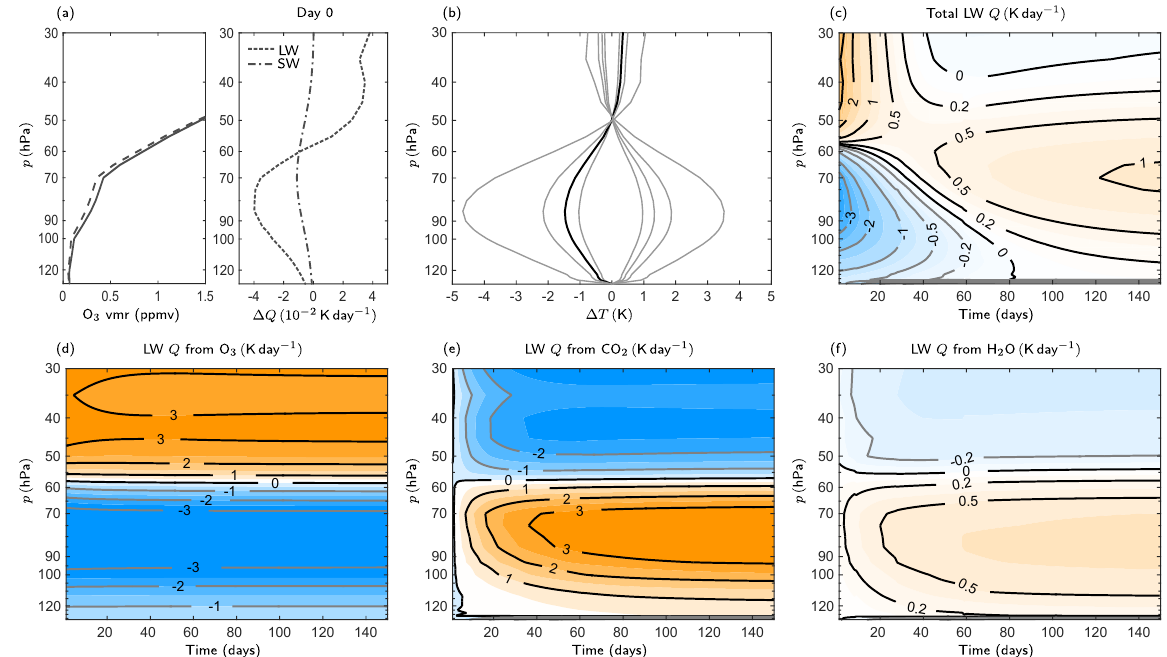
Figure A1. (a) Left: ozone reference profile (solid) and perturbed profile (dashed) used in the FDH calculation. Right: instantaneous change in heating rate from perturbation. (b) Temperature change resulting from the ozone perturbation. The calculation is done at the Equator on 1 January. The lines correspond to perturbations of A 0 = − 0 . 2, − 0.1, − 0.07 (black line), − 0.05, 0.05, 0.07, 0.1, and 0.2ppmv from left to right at the maximum temperature change (see text for more details). For the perturbation of − 0.07ppmv, (c) shows total longwave heating rate from all the constituents, (d) longwave heating rate due to ozone, (e) longwave heating rate due to carbon dioxide, and (f) longwave heating rate due to water